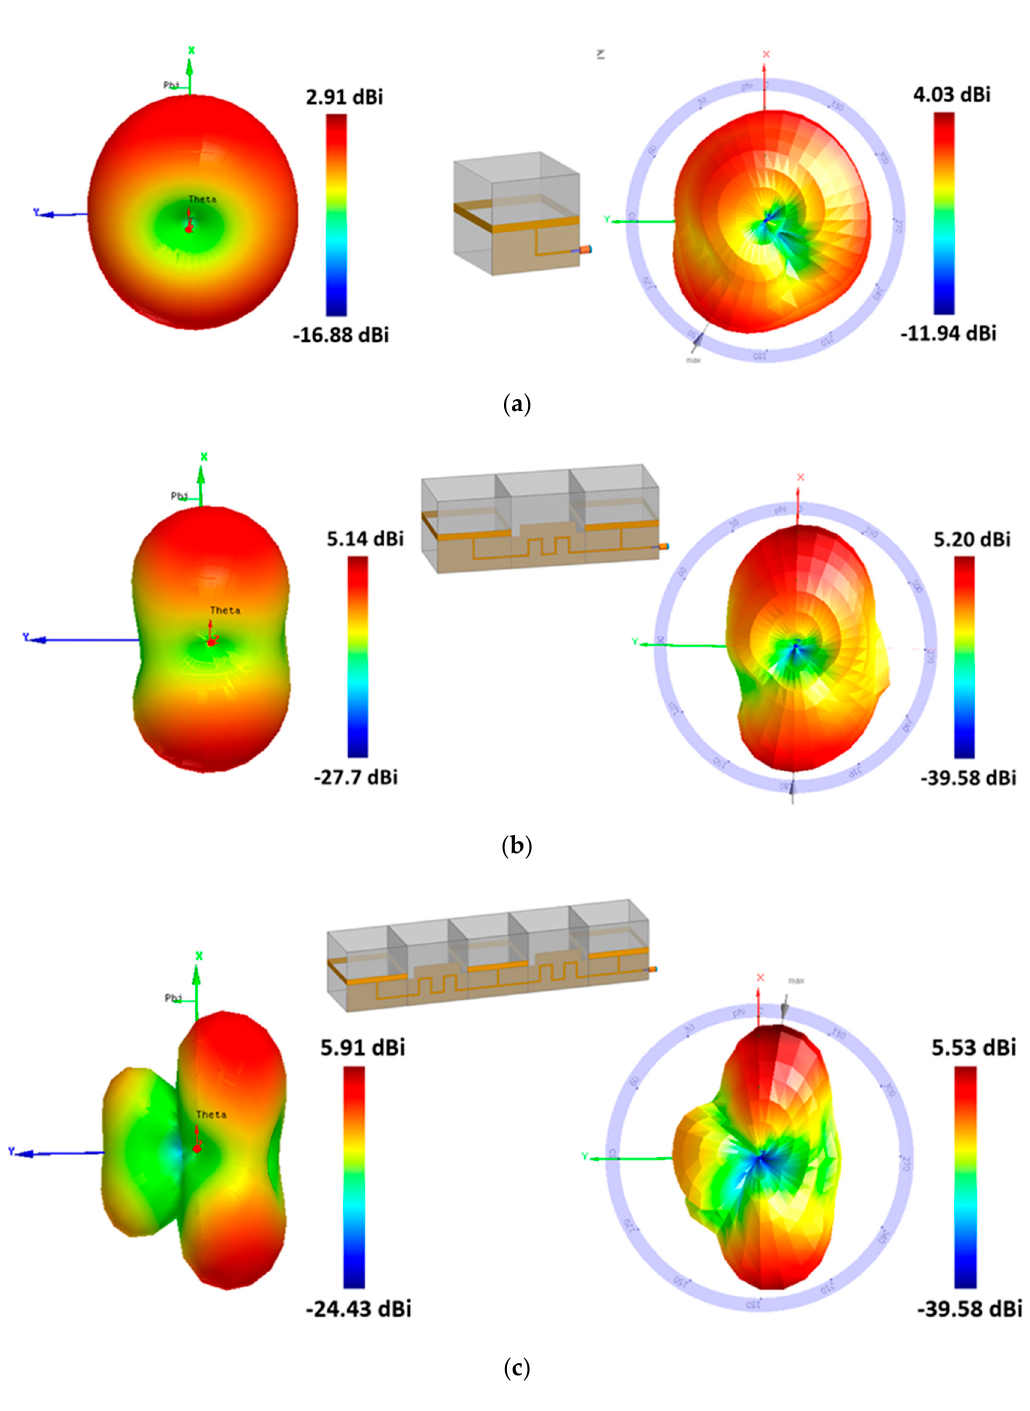
Figure 8. Simulated and measured 3D radiation patterns at 1.39 GHz for ( a ) the single antenna and ( b ) two-element antenna array and ( c ) three-element antenna